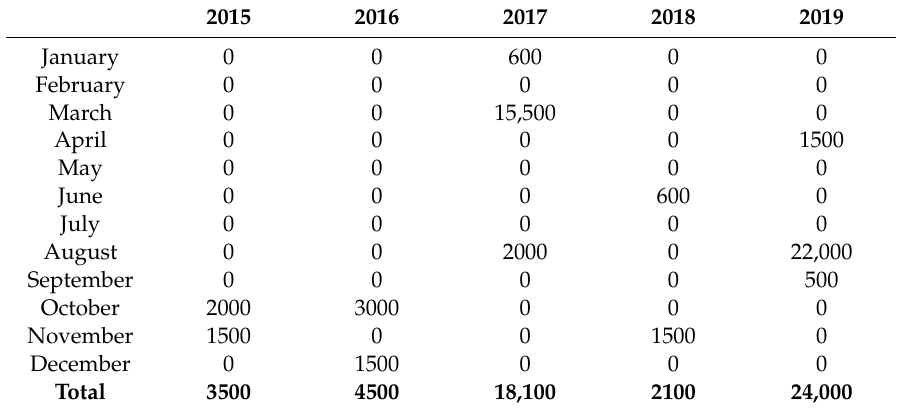
Figure 6. La Marjal Floodplain Park. Source: Authors. Table 3. Evolution of stored rainwater in La Marjal Floodplain Park (2015–2019) (m 3 ).